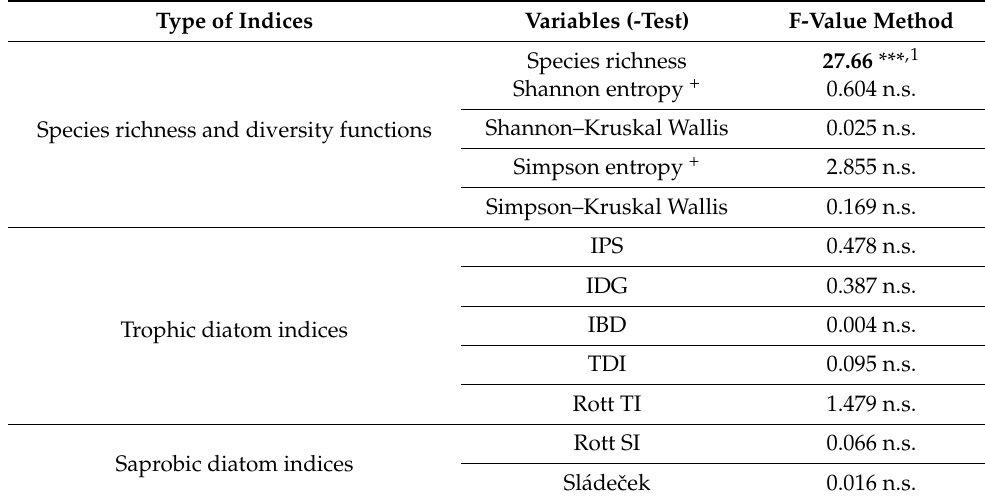
Table 3. Analysis of variance results of the parametric values. Interactions calculated only if methods were significantly different. In bold, significant